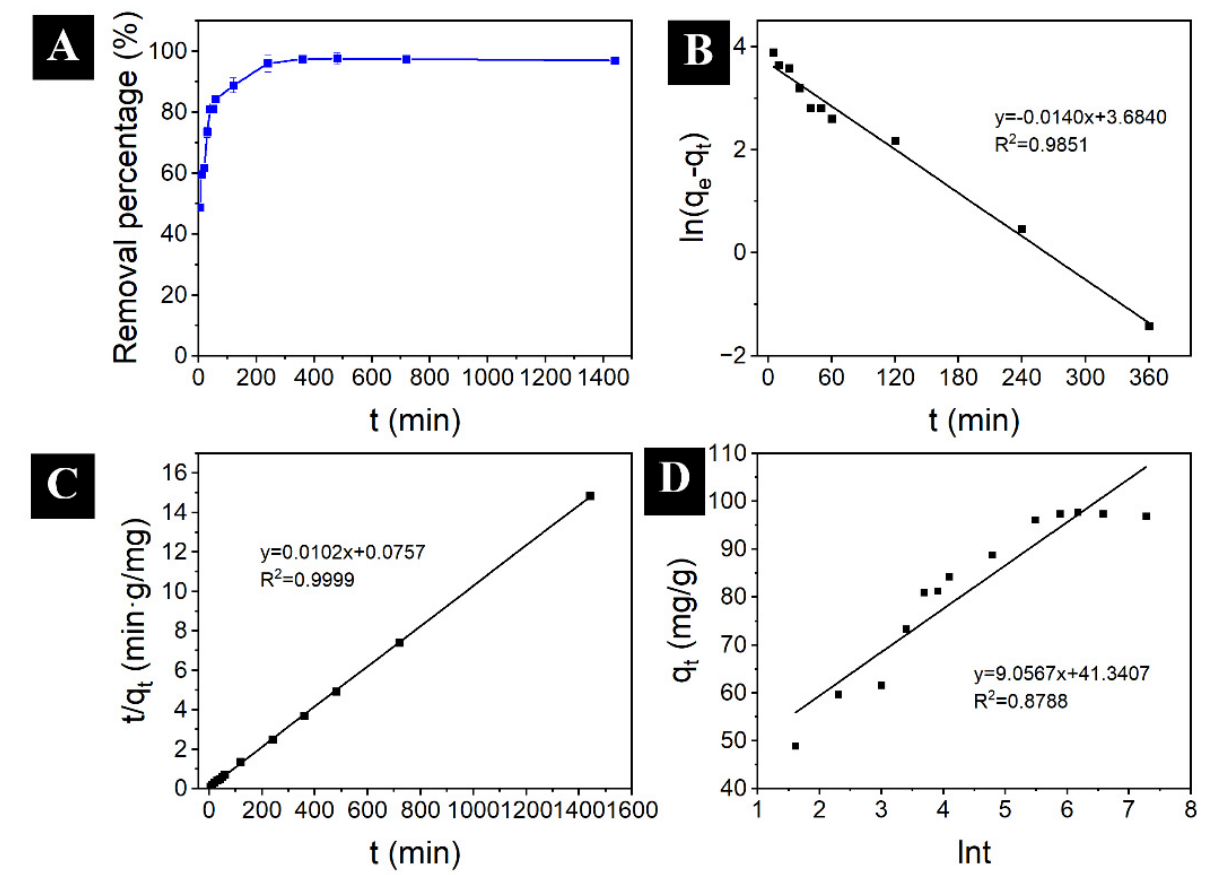
Figure 5. Kinetics studies. ( A ) V(V) removal percentage versus time; ( B ) fitted results for linearized pseudo − first order; ( C ) pseudo − second order kinetic models; and ( D ) Elovich model. Conditions: V(V) initial concentration = 100 ppm, CS 2 C@SBA − 3 dosage = 1.0 g/L, pH value = 3.0, experimental temperature = 298 K. Table 2. The parameters of kinetic and thermodynamics models for the adsorption of V(V) on CS 2 C@SBA − 3.